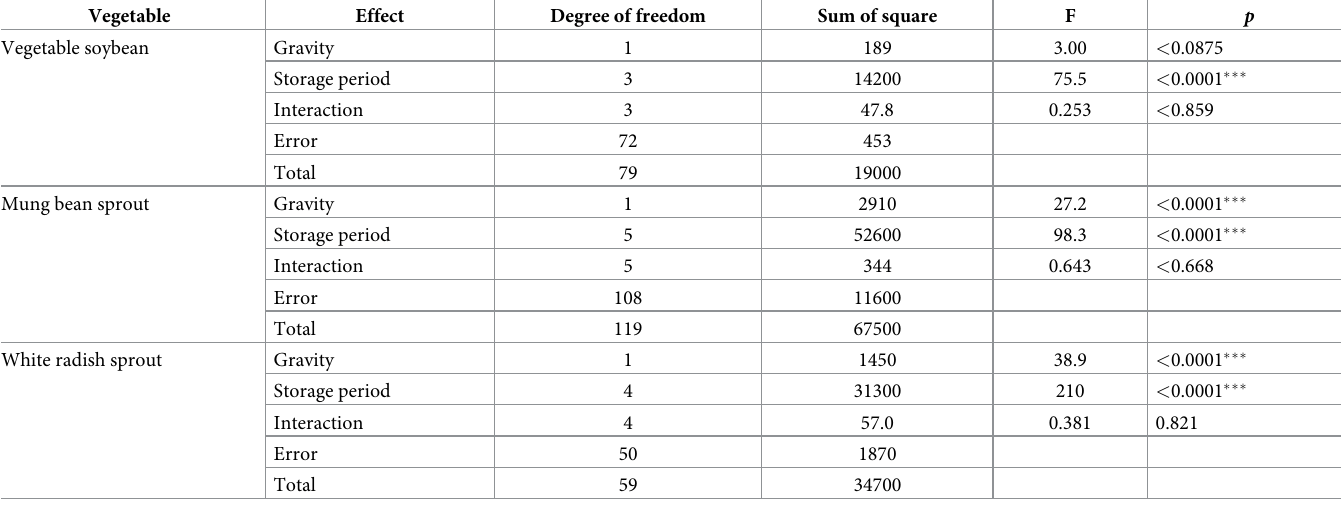
Table 1. Two-way analysis of variance on the effect of gravity and storage period on mass retention rate of vegetables. Vegetable Vegetable